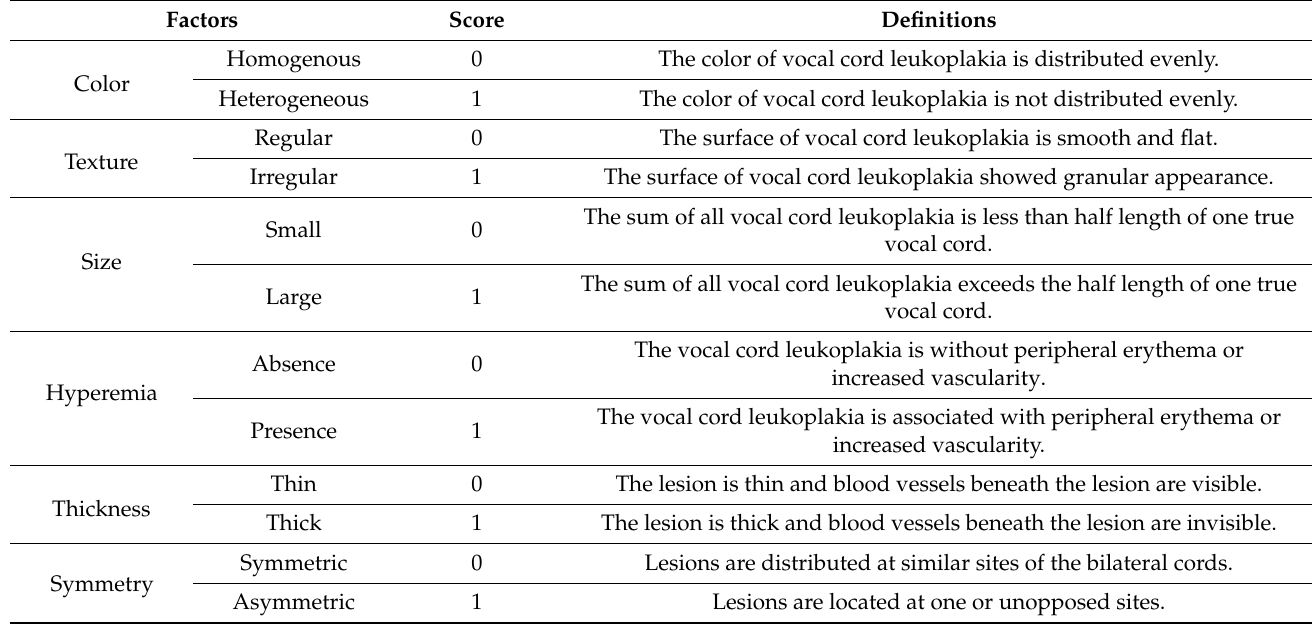
Table 5. Clinical scoring of leukoplakia according to Fang et al. (2016) [21].